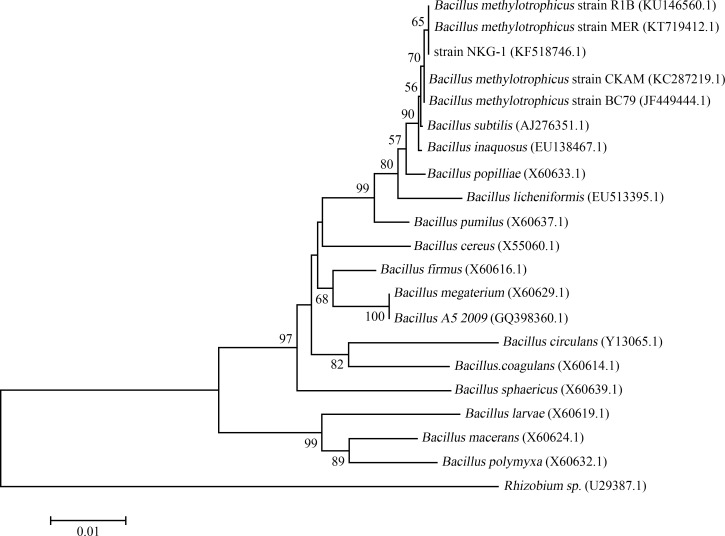
Phylogenetic tree based on 16S rDNA gene sequences from related species of the genus Bacillus constructed using the neighbor-joining method with 1,000 bootstrap replicates.Branch length is indicated at each node.